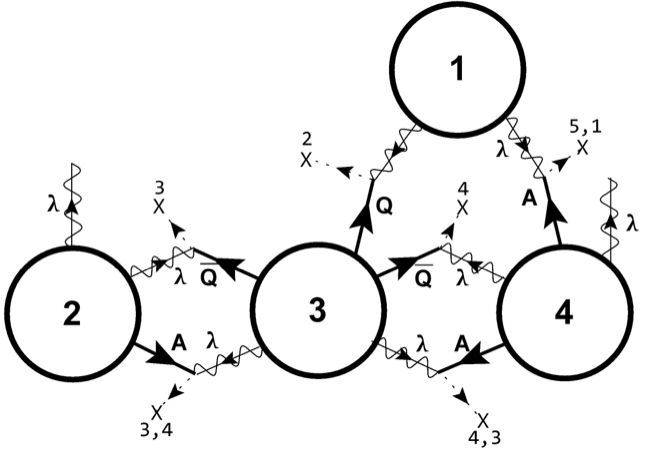
Figure 16: A sketch of the multi-monopole composite with + + 2 when ≫ B B are large. The gauge group breaks to SU ( 2 ) . The antisymmetric and squark 1 2 VEVs, (C.22) and (C.23), are represented as a cross with their color